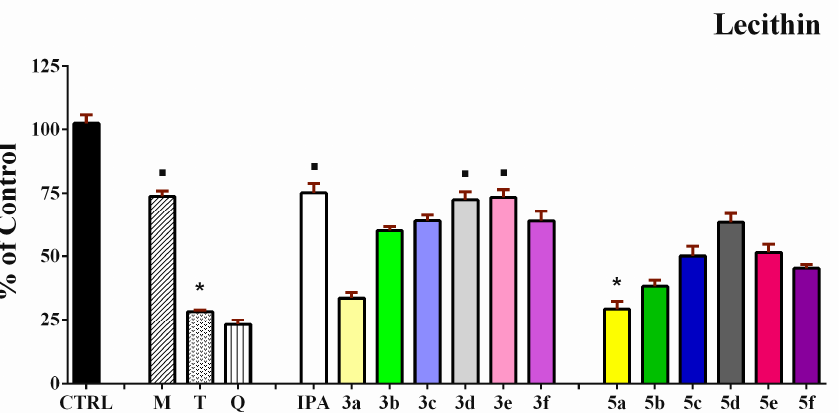
Figure 4. Effect of the tested compounds (90 µ M) in the in vitro model system of Fe(II)-induced Figure 4. E ff ect of the tested compounds (90 µM) in the in vitro model system of Fe(II)-induced lecithin (1 mg/mL) peroxidation. Data concerning the effect of the references melatonin (M), Trolox (T) lecithin (1 mg/mL) peroxidation. Data concerning the e ff ect of the references melatonin (M), Trolox and quercetin (Q) were presented All data are expressed as means ± SEM. The effect of compounds (T) and quercetin (Q) were presented All data are expressed as means ± SEM. The e ff ect of labeled with (cid:4) is considered statistically identical to the effect of melatonin. Respectively, * labels the compounds labeled with ∎ is considered statistically identical to the e ff ect of melatonin. compounds with an effect statistically identical to Respectively, * labels the compounds with an e ff ect statistically identical to Trolox.